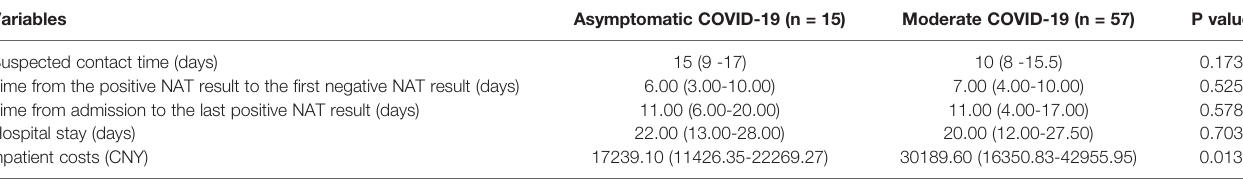
TABLE 3 | Characteristics of inpatients with asymptomatic COVID-19 and inpatients with moderate COVID-19.